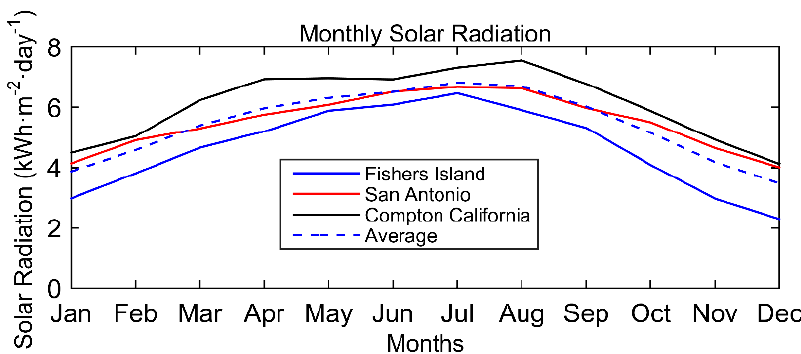
Figure 2. Monthly solar radiation for different locations.